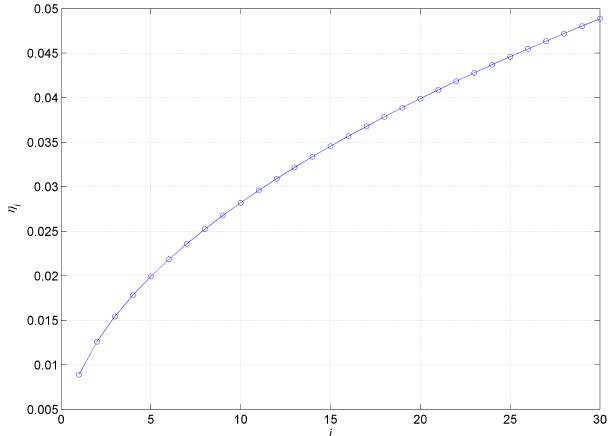
Figure 2. Example of the adjusted scaled weights ( η i ) vs. order numbers in the case of n = 30 and order weight r = 0.5. Note that η i is the probability of being selected and increases as the order is increased, so that higher values are subject to being selected more often than lower values, leading to a positive